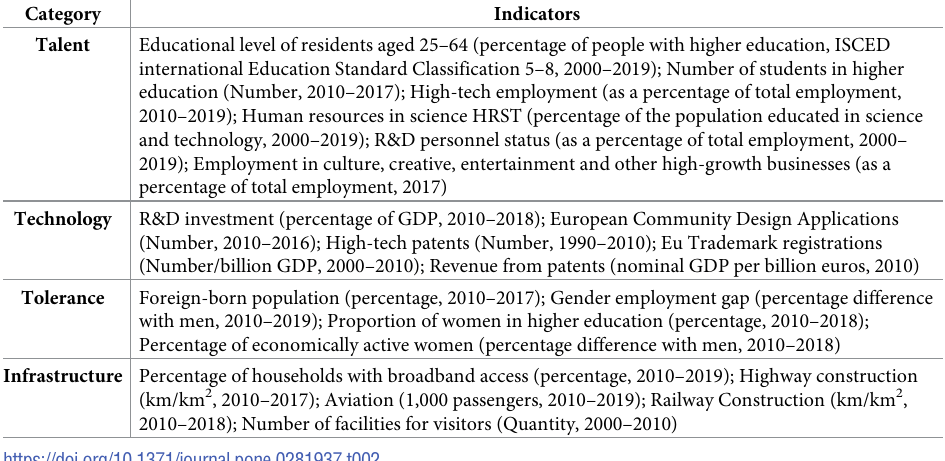
Table 2. Four categories of indicators for 52 cities obtained by